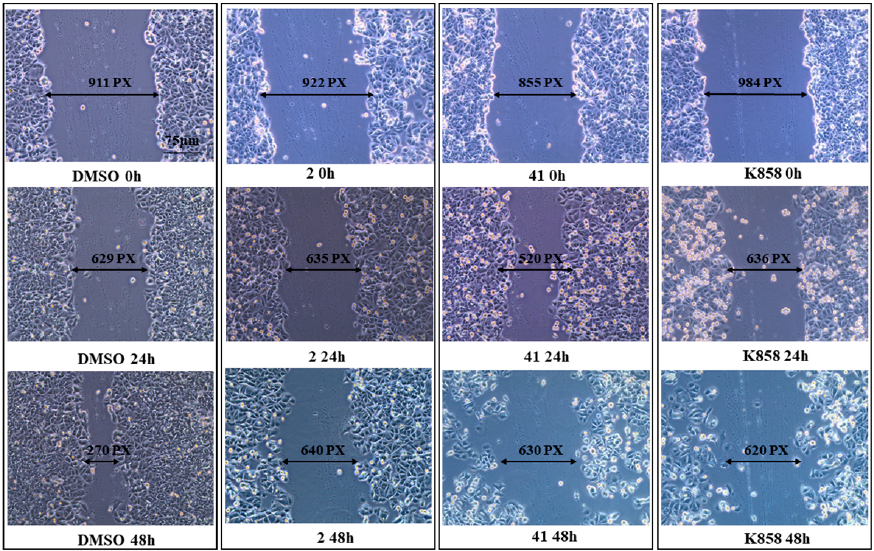
Figure 8. Scratch wound healing assay performed in MCF7 cells treated with compounds 2 (1.5 μ M), 41 (5 μ M) and K858 (10 μ M). Images were taken at 0, 24, and 48 h after the confluent monolayer of cells was wounded. DMSO: control vehicle. The most representative of three separate experiments is shown. Magnification 20×.